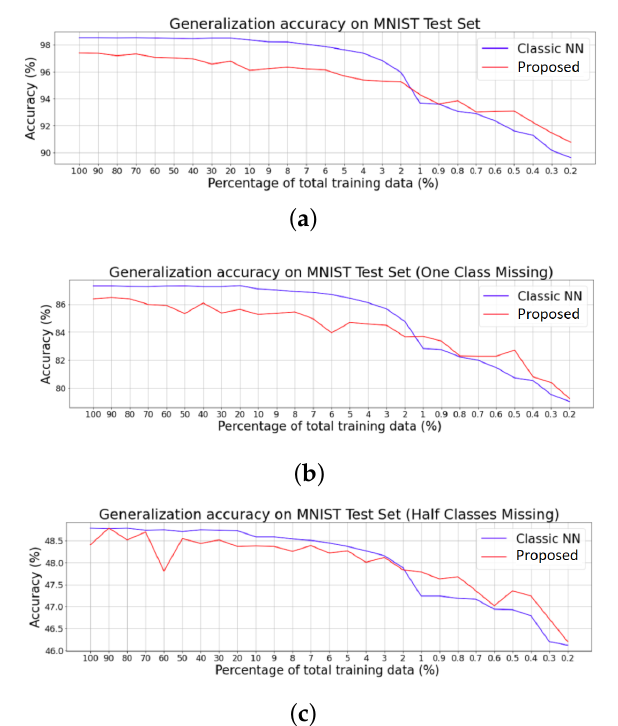
Figure 3. Results of our data scarcity experiments on the MNIST dataset: ( a ) all classes present in training, ( b ) class ‘1’ missing from training, and ( c ) half of classes missing in